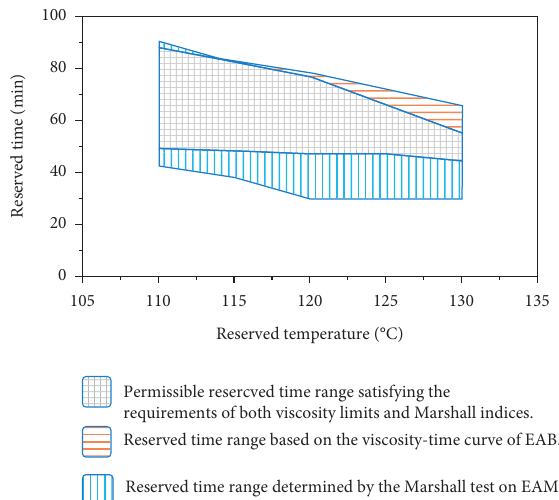
Figure 17: Reserved time based on evolution of both viscosity and Marshall stability [127]. Note: EAB � epoxy asphalt binder; EAM � epoxy asphalt mixture.